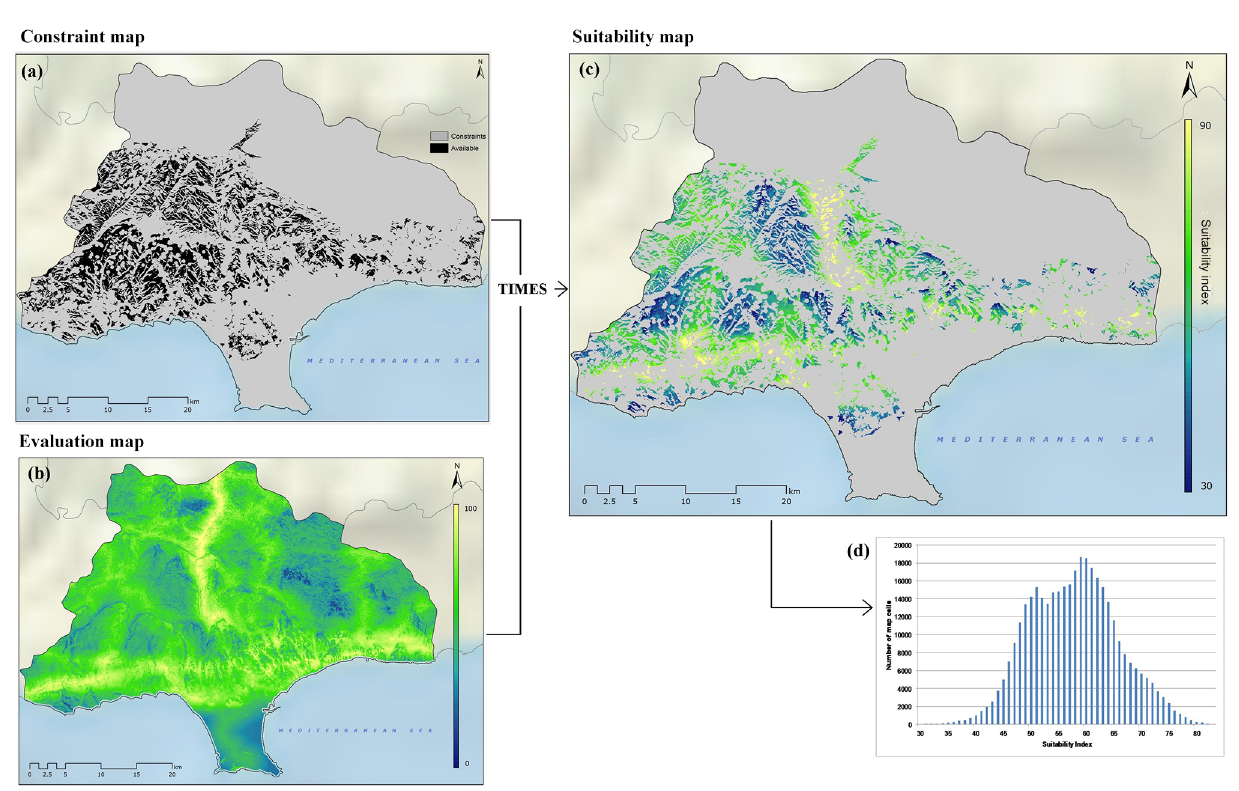
Figure 5. (a) Constraint map, (b) evaluation map, (c) the final suitability index map of study area as derived from the merging of constraint map and evaluation map, and (d) distribution of suitability index pixels over the final